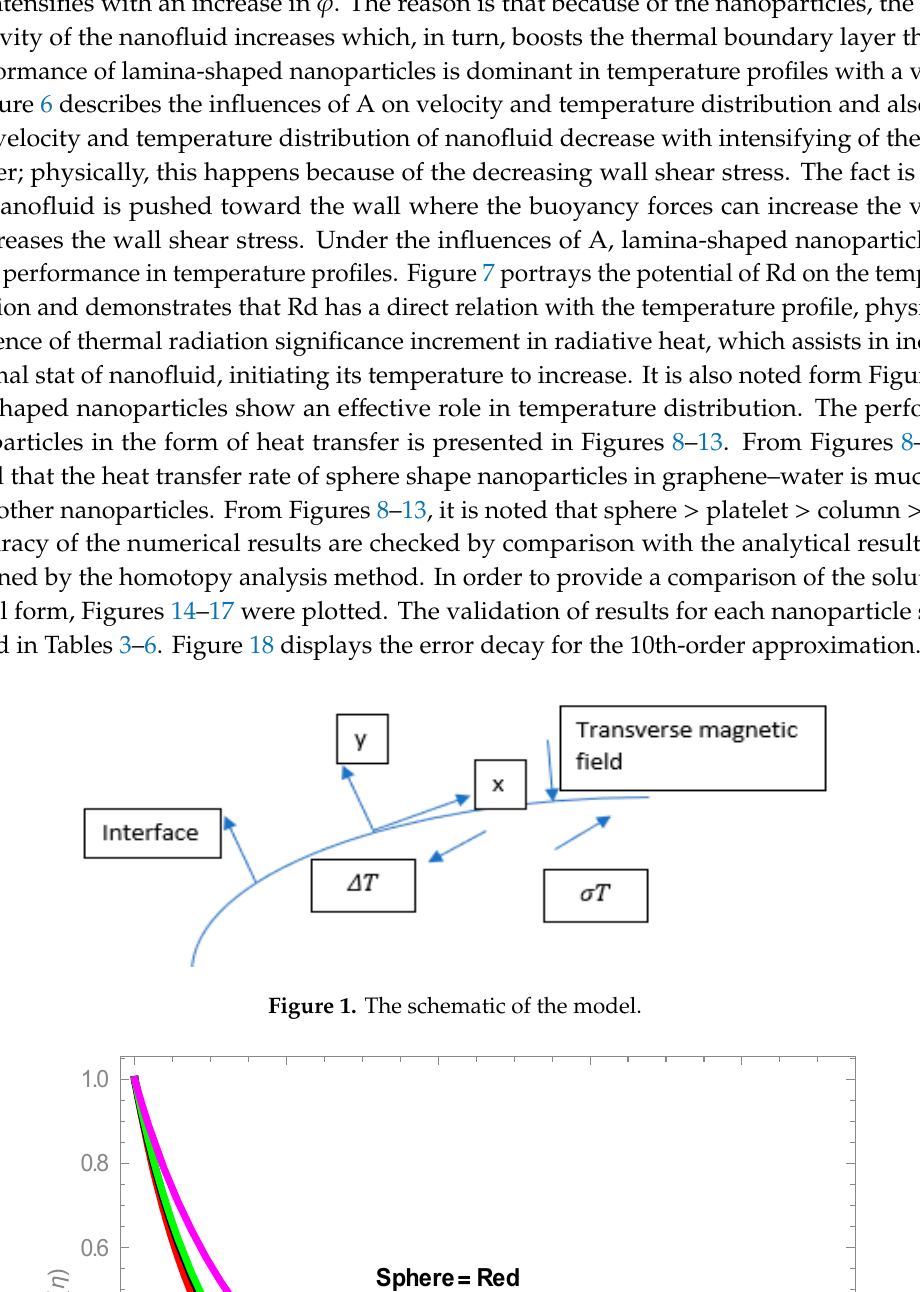
Figure 3. (cid:1858) (cid:4593) (η) and (cid:2016)(η) for dissimilar values of (cid:1839) .